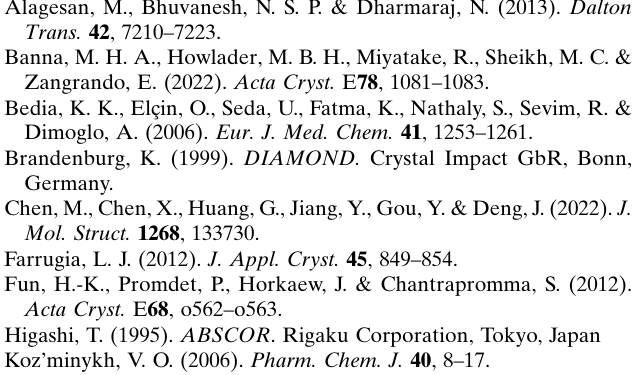
Crystal data Chemical